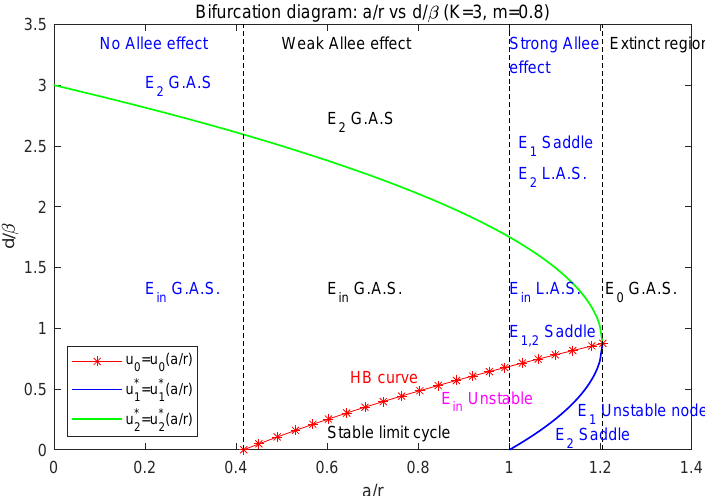
) , where parameters K = 3, m = 0.8. , d r β